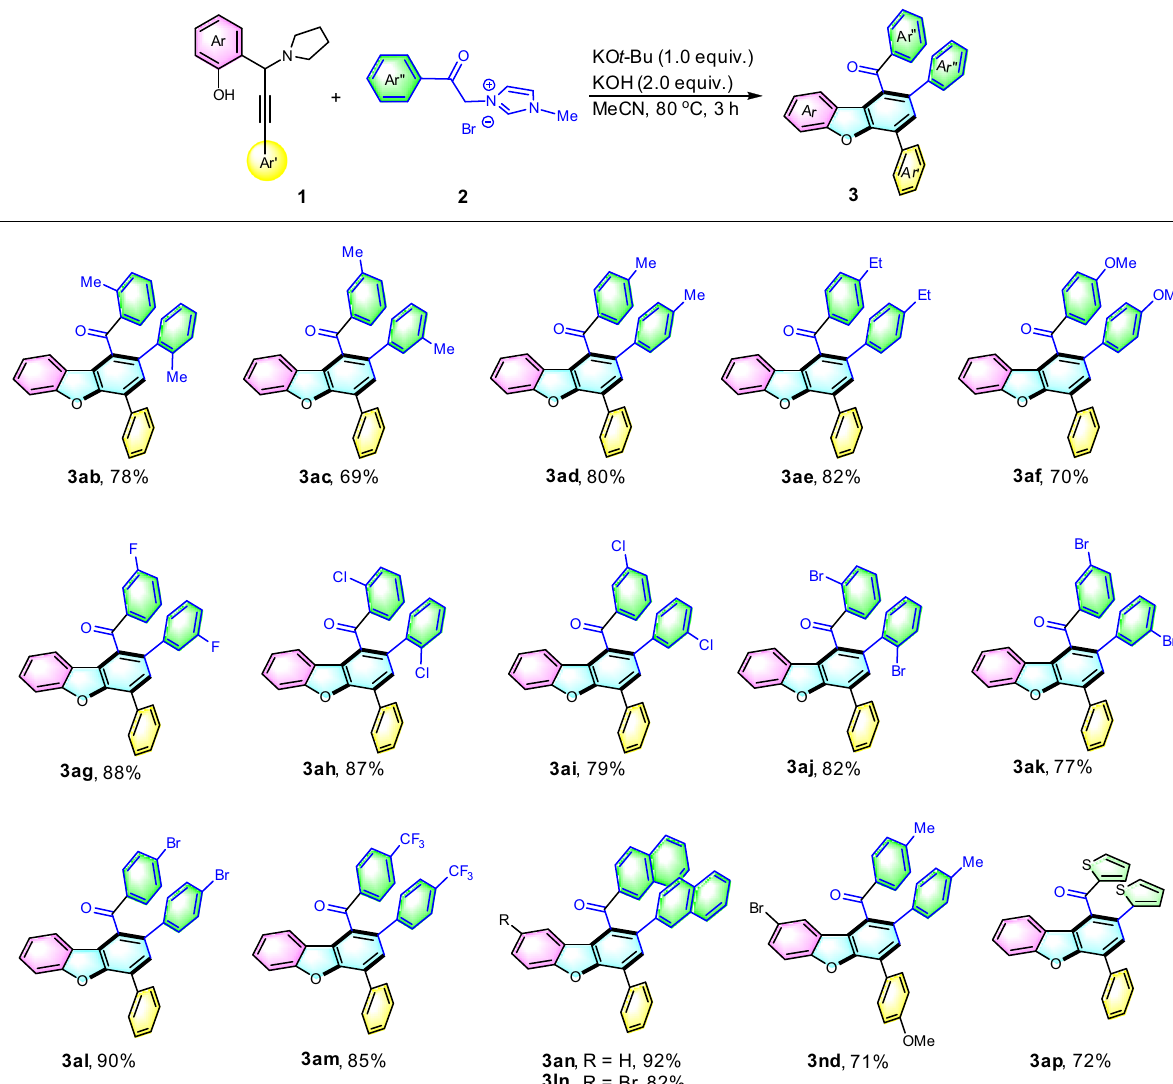
Fig. 3 Substrate scope of propargylamines and 1-methyl-1 H -imidazolium methylides. Reaction conditions: 1 (0.2 mmol), 2 (0.4 mmol), KO t -Bu (0.2 mmol), KOH (0.4 mmol) were stirred in acetonitrile (2 mL) at 80 °C for 3 h under bench-top air atmosphere. Isolated yields were